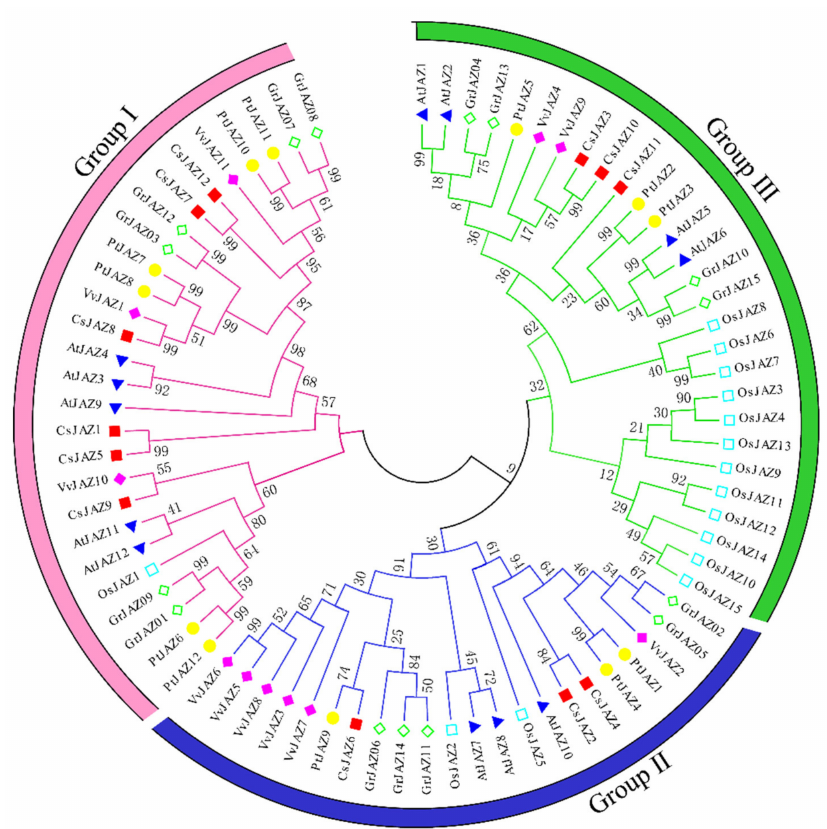
Figure 1. Phylogenetic relationship of JAZ proteins from Camellia sinensis (Cs), Arabidopsis thiatina (At), Oryza sativa (Os), Vitis vinifera (Vv), Populus trichocarpa (Pt), and Gossypium raimondii (Gr). The unrooted phylogenetic tree was constructed using MEGA 6 by the neighbor-joining method, and the bootstrap test was performed with 1000 iterations. The three groups are indicated with camber